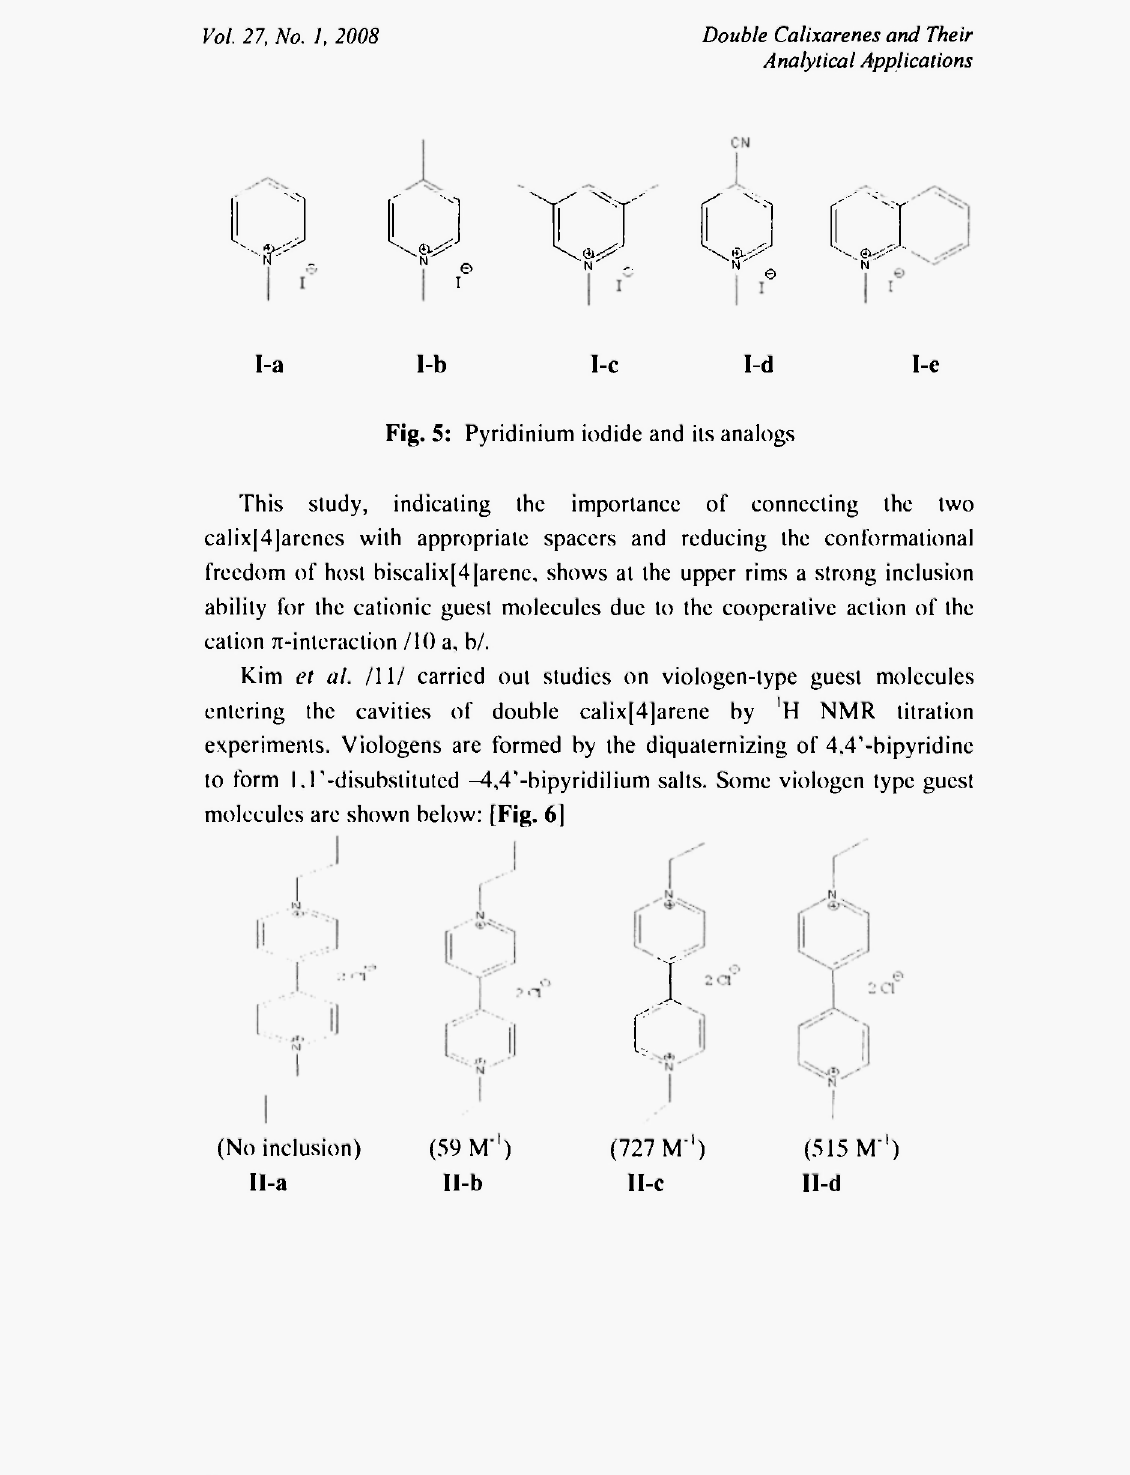
Fig. 5: Pyridinium iodide and its